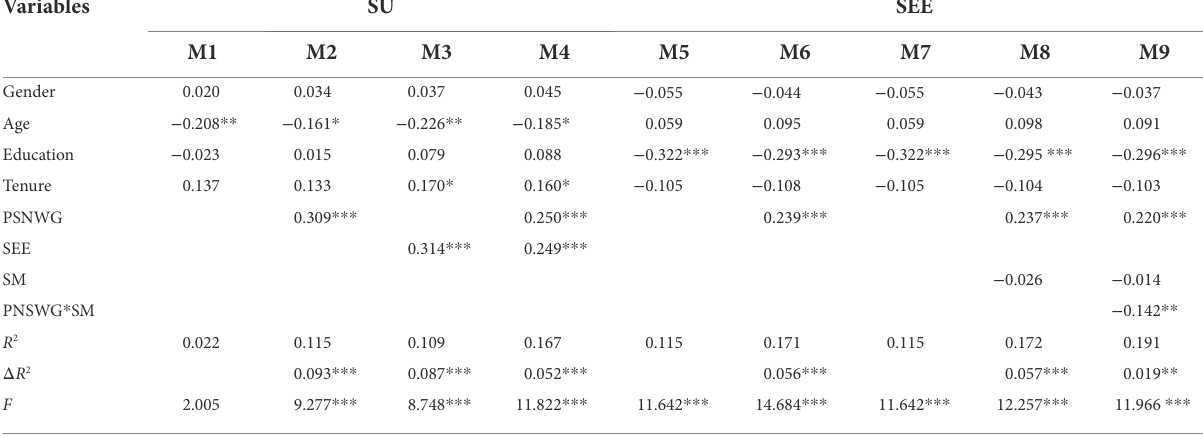
TABLE 3 The results of hierarchical regression analysis. Variables